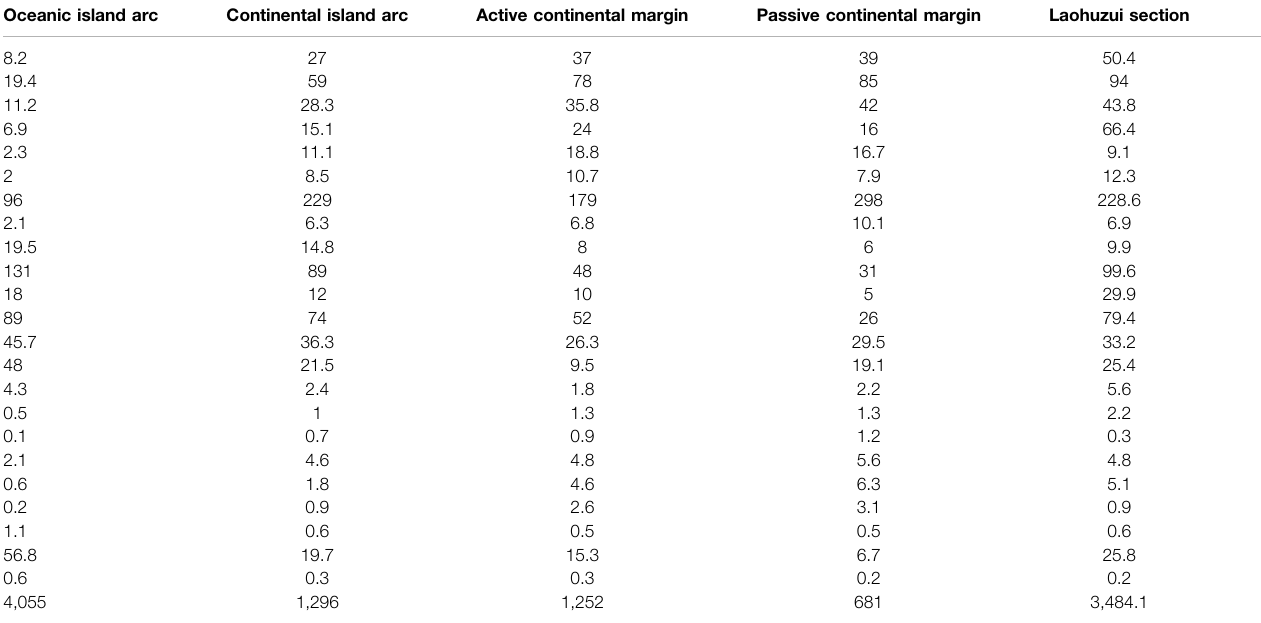
TABLE 2 | Comparison of the chemical composition of sandstone in different tectonic settings in the Laohuzui section. Oceanic island